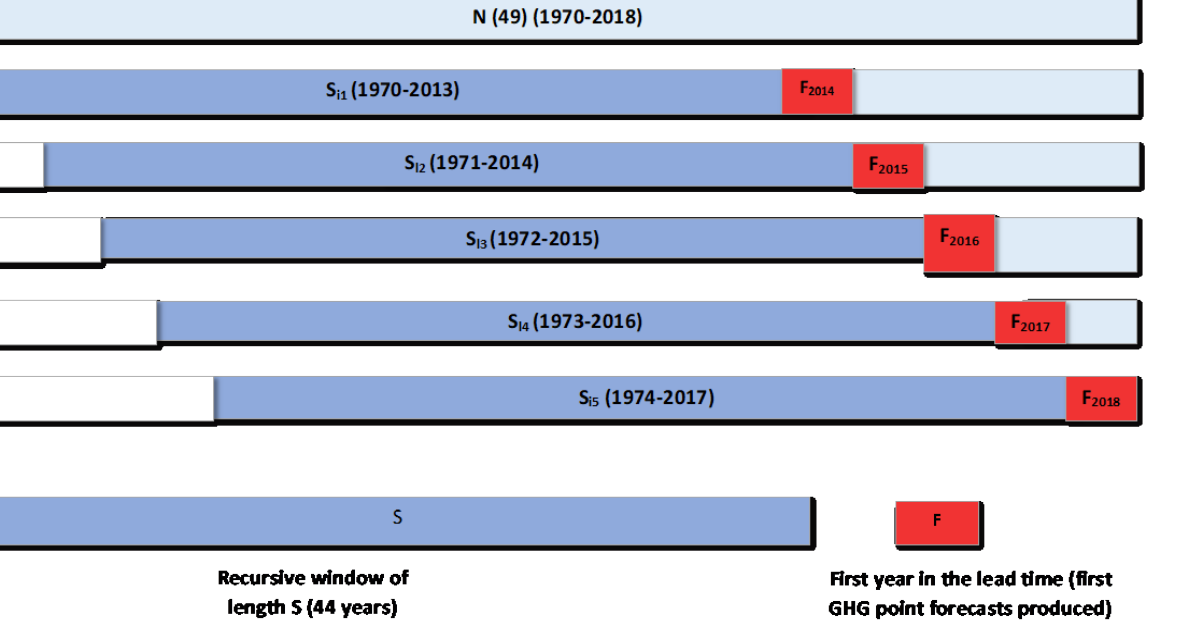
Figure 6. The fixed-length recursive window out-of-sample forecasting technique.